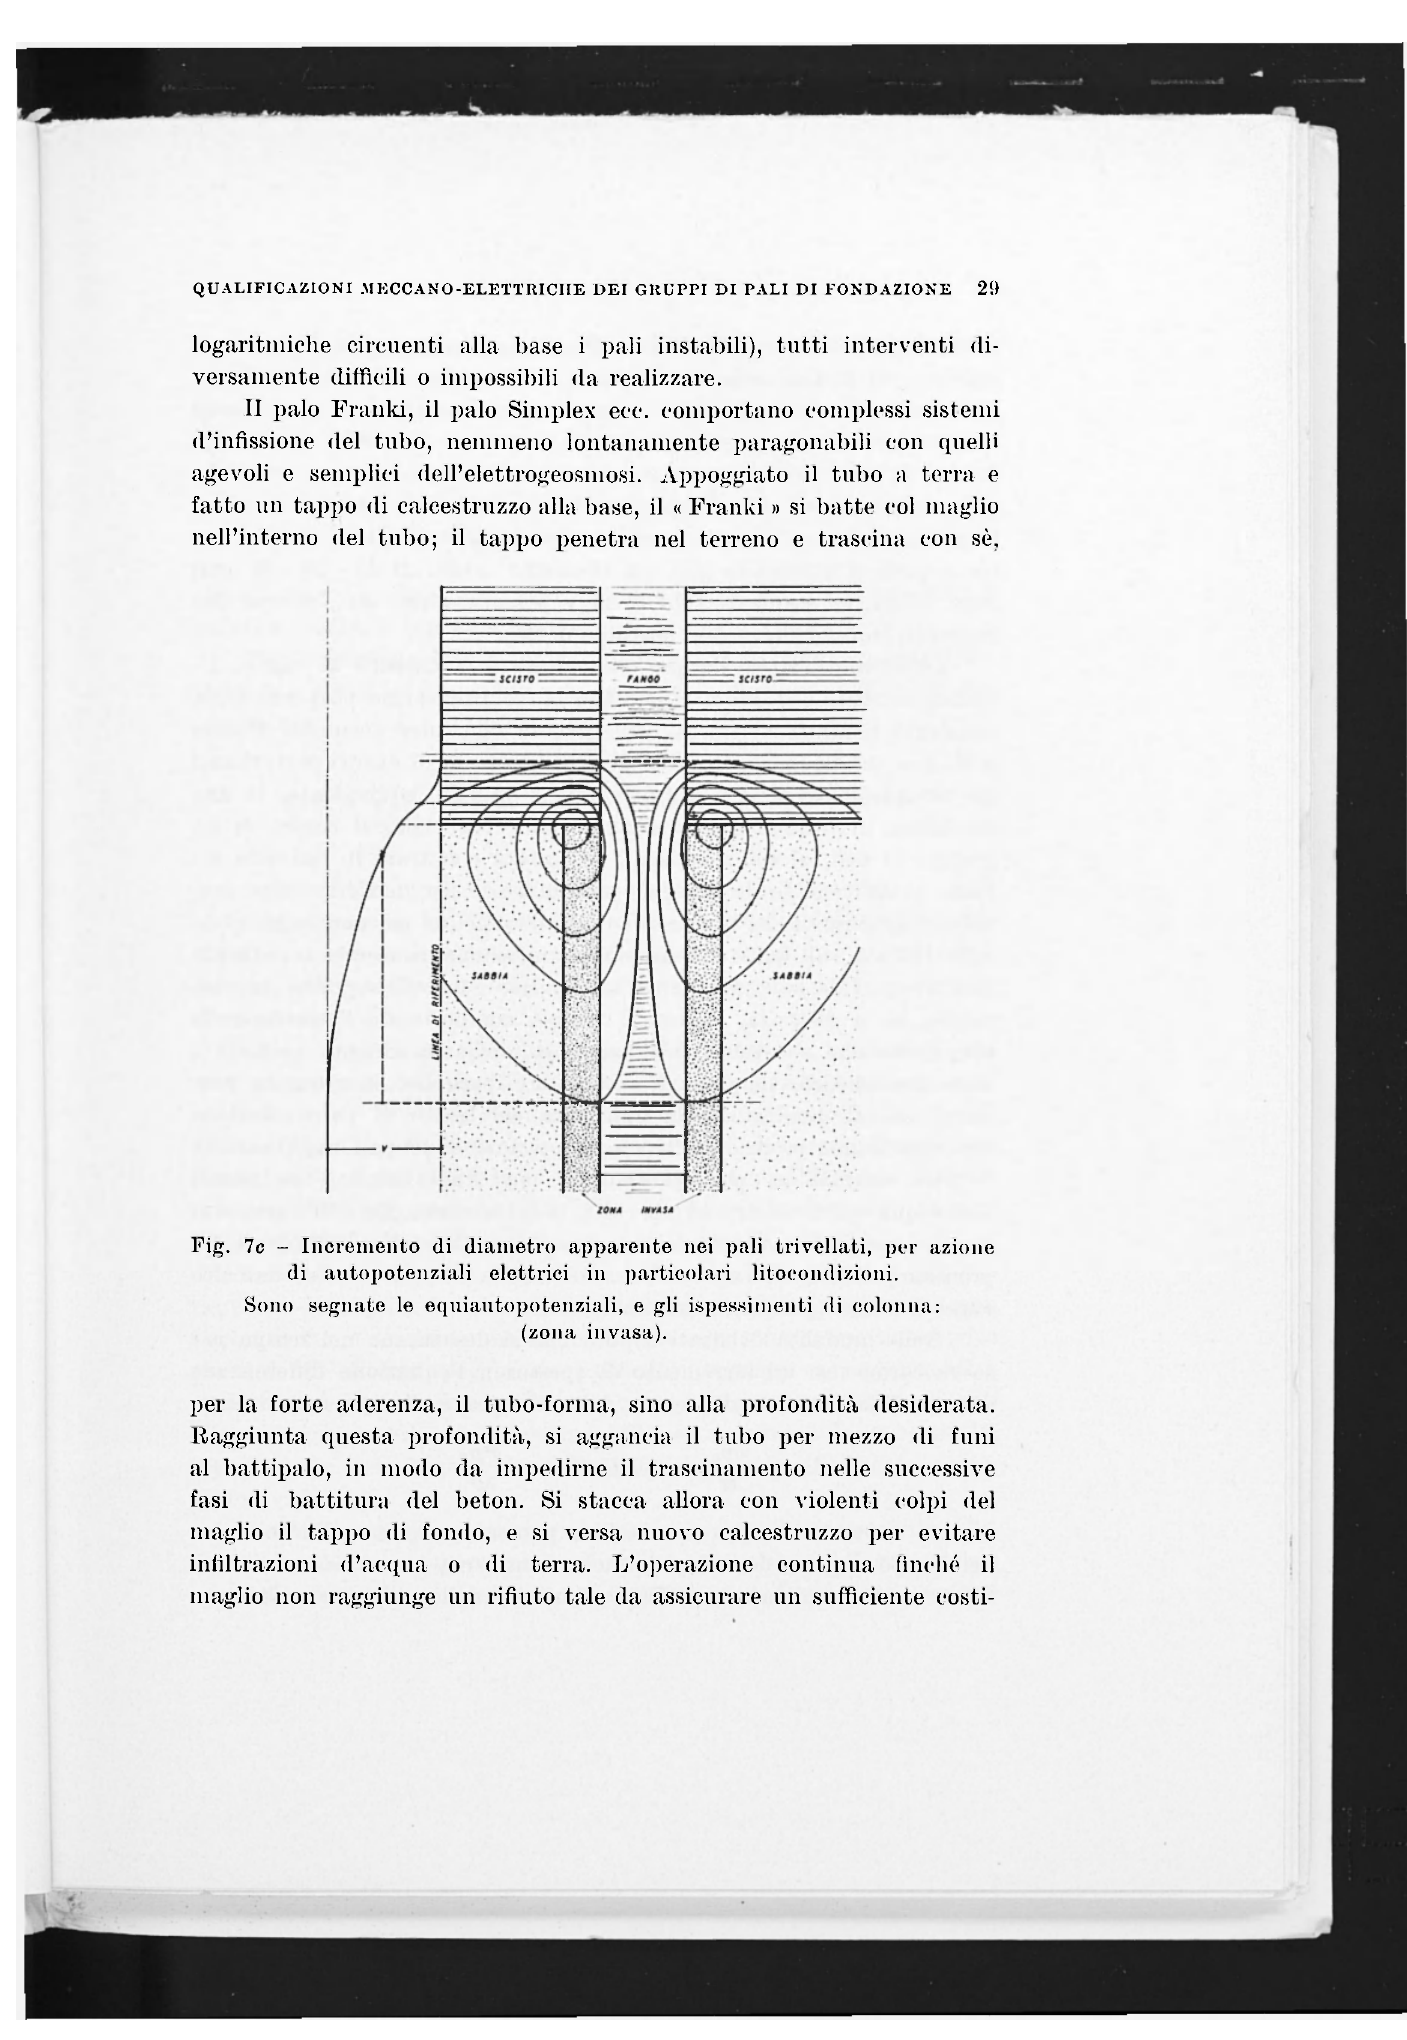
Fig. 7c - Incremento di diametro apparente nei pali trivellati, per azione di autopotenziali elettrici in particolari